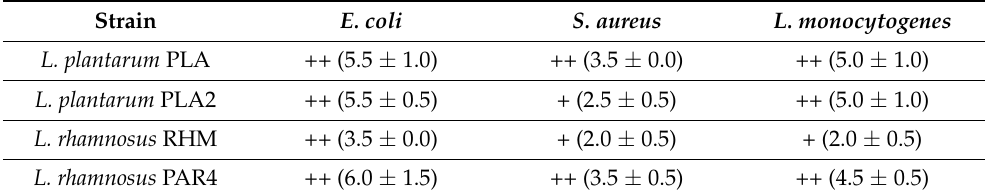
Table 1. Antibacterial activity against foodborne pathogenic bacteria. Values are expressed as the radius (mm) of the inhibition halos. (+) Inhibition zones between 1–3 mm; (++) inhibition zones greater than 3 mm. Values represent the mean ± SD of three different experiments.